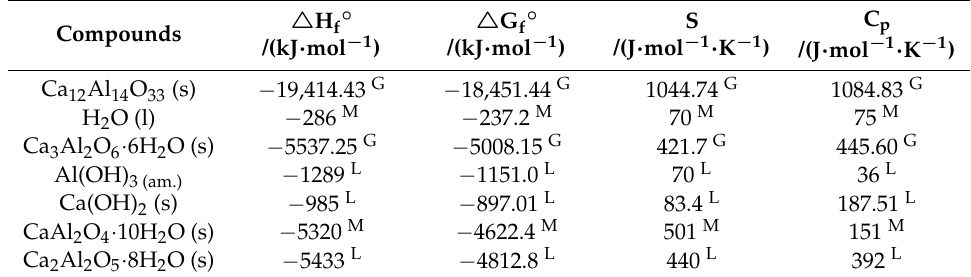
Table 3. Standard thermodynamic properties at 298 K.